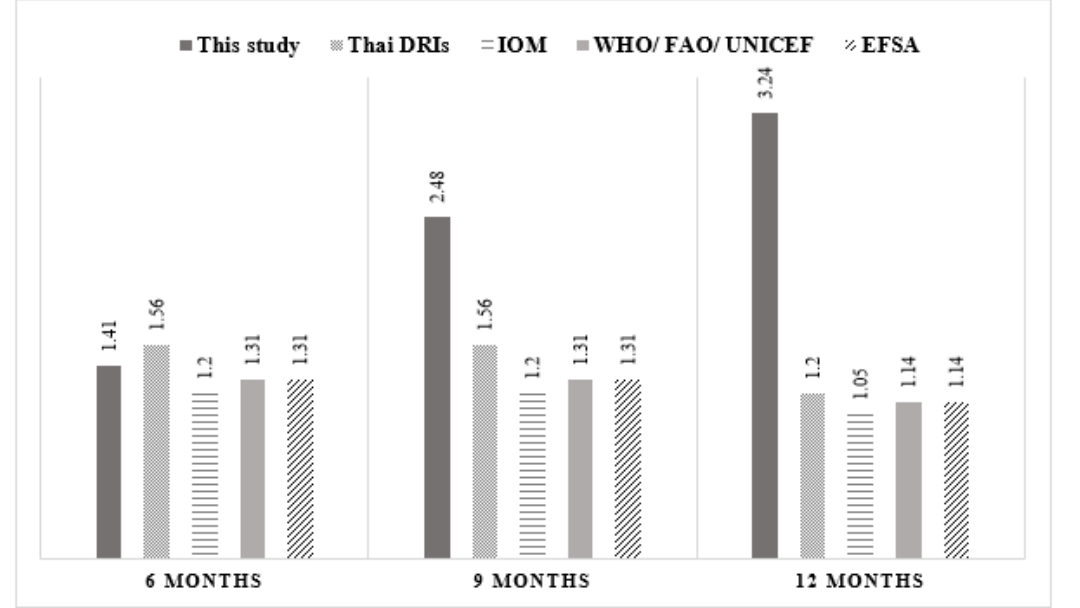
Figure 1. Comparison of protein intake (protein weight ratio) between this study and the Thai and international recommendations.